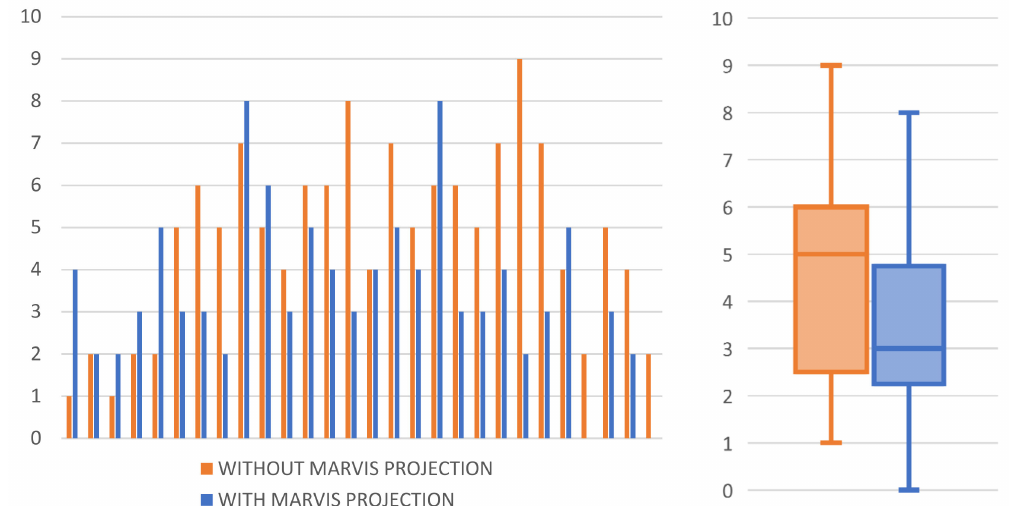
Figure 18. The number of correct attempts for each participant (on the left ); a box-and-whisker diagram presenting the distribution of correct attempts (out of ten in total) for each participant (on the right ). The boxes present the first and third quartiles while the ends of the whiskers show the minimal and maximal values in the group.